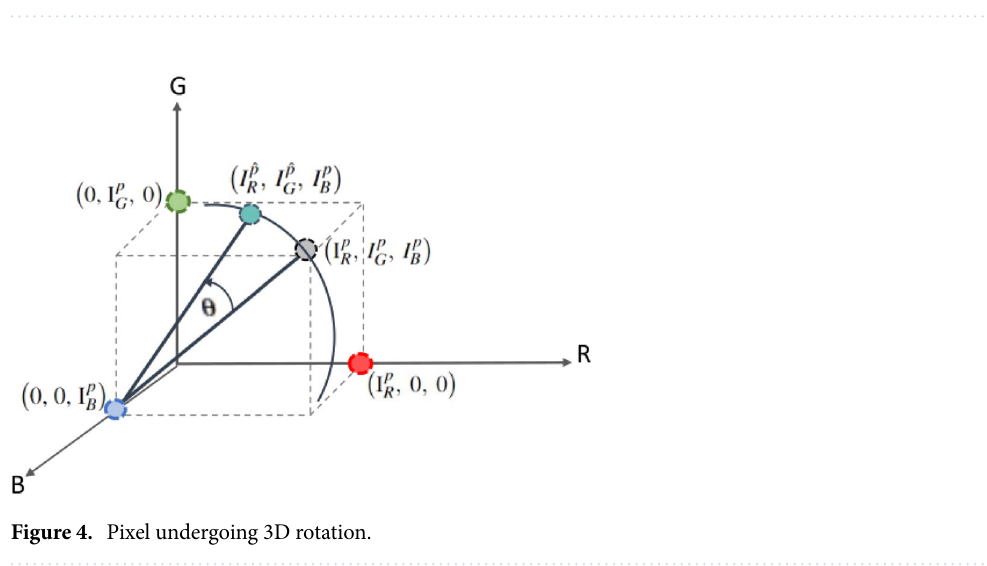
Figure 3. 3D cube geometrically representing the RGB colour space.